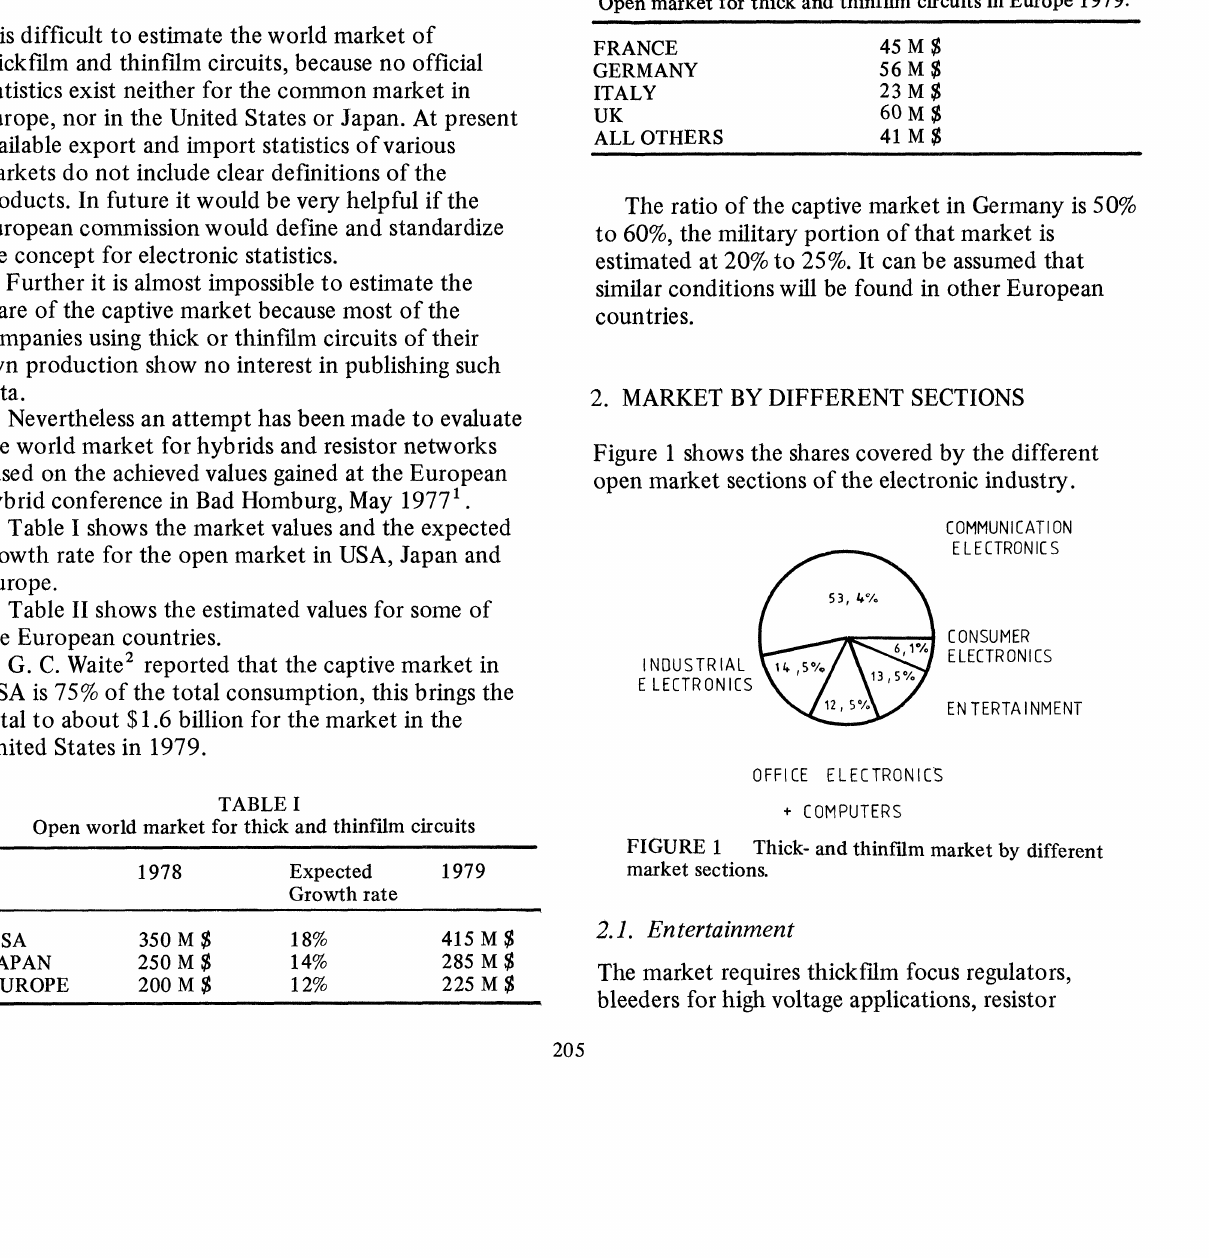
TABLE Open world market for thick and thinfilm circuits